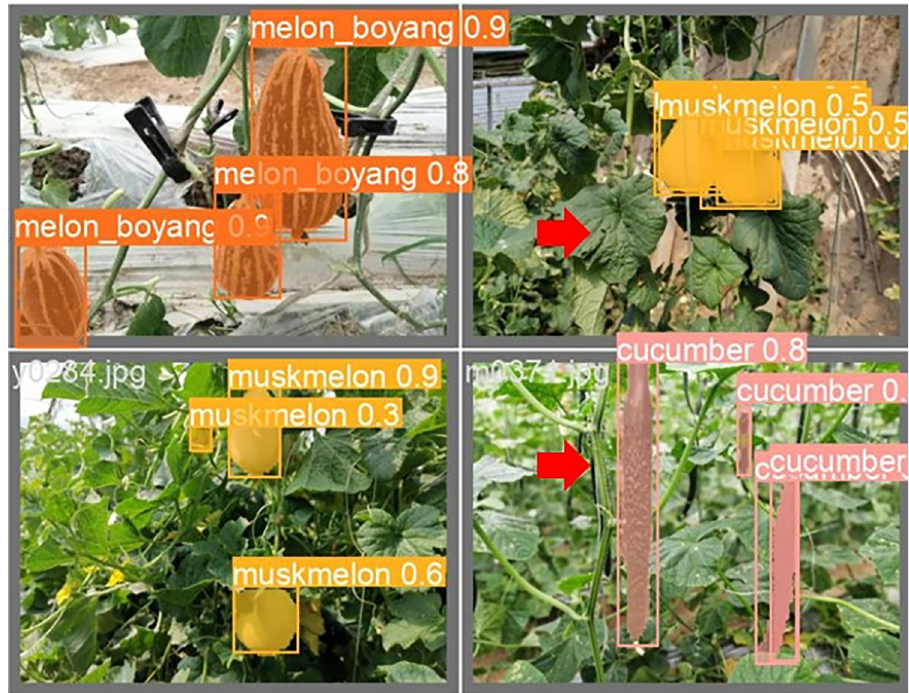
Fig 13. Image results of YOLOv5-ShuffleNetv2.